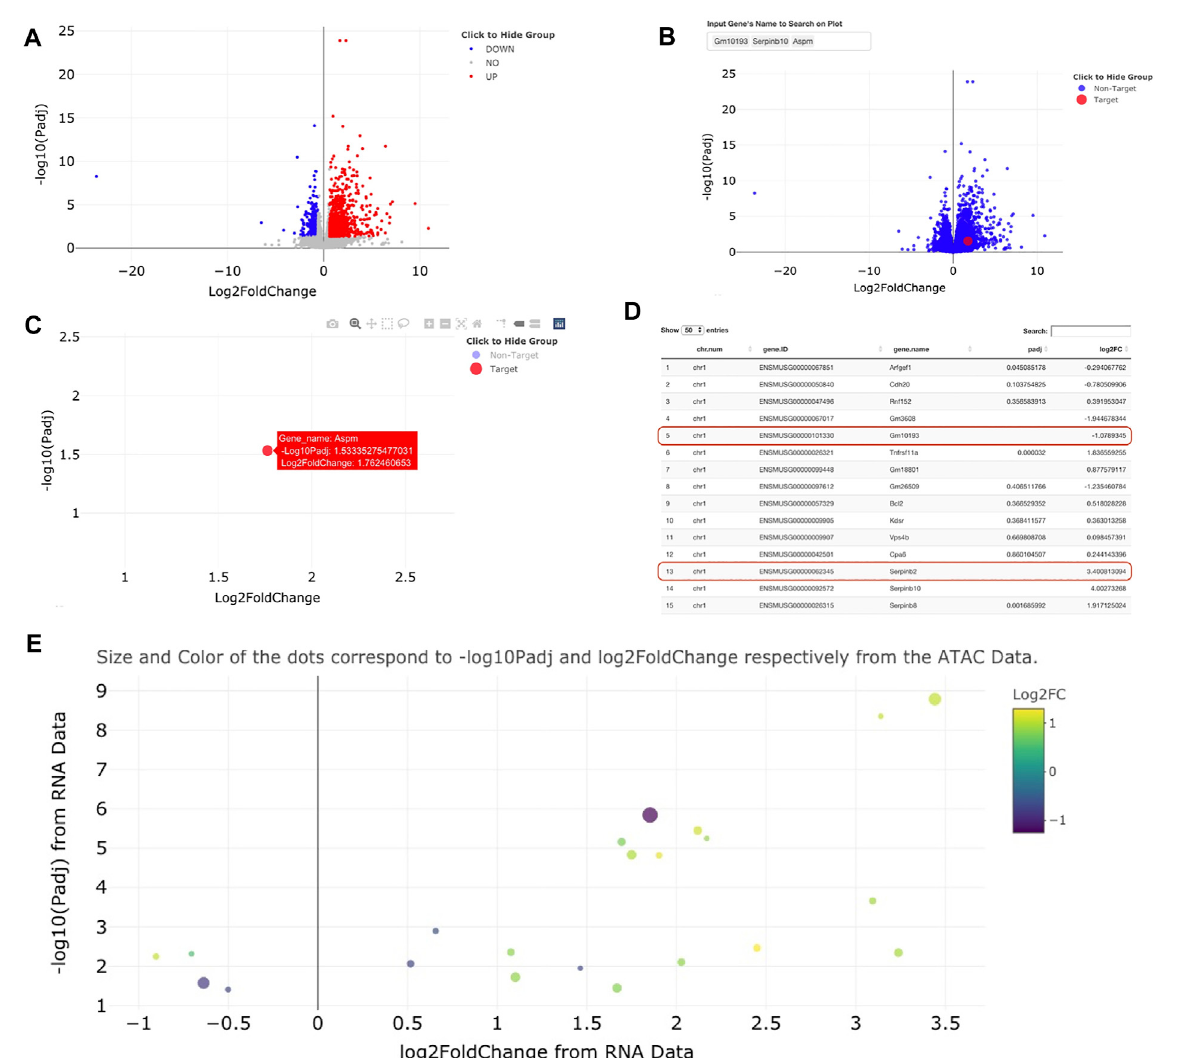
FIGURE 2 ExamplevisualizationsofsampleRNA-seqandATAC-seqdatausinggenomeSidekick. (A) VolcanoplotofRNA-seqdatashowsdown-regulated genes in blue, upregulated genes in red, and non-signi fi cant genes in gray. Thresholds for p -value and log2FoldChange can be adjusted within genomeSidekick. (B) Searching for a particular gene(s) will highlight the target gene in red and mark the non-target genes in blue. In the example query for three genes, only one is found and visualized on the graph. (C) The non-target genes can be hidden by clicking on the Non-Target label in the legend (resulting in a grey label) and un-hidden by clicking the label a second time. Details about any gene shown on the interactive volcano plot can be shown by hovering over the dot on the plot. (D) Looking at the RNA-seq data upload page, genes without a p -value are not plotted on the volcano plotand therefore will not return any results when queried on the graph (see red lines). Common RNA-seq analysis packages donotevaluateall genesinthegenomedueto lowdetection,andthisvariesbyexperiment.Panels (A) through (D) use RNA-seq dataasan example, but the functionalities are the exact same for ATAC-seq data. (E) Once both RNA-seq and ATAC-seq data sets are uploaded, they can be integrated intoonegraphusingeithertheRNA-seqorATAC-seqdataasthebase.Exampledatashownhavepadj < 0.05andFDR < 0.1intheRNAandATAC-seq datasets,